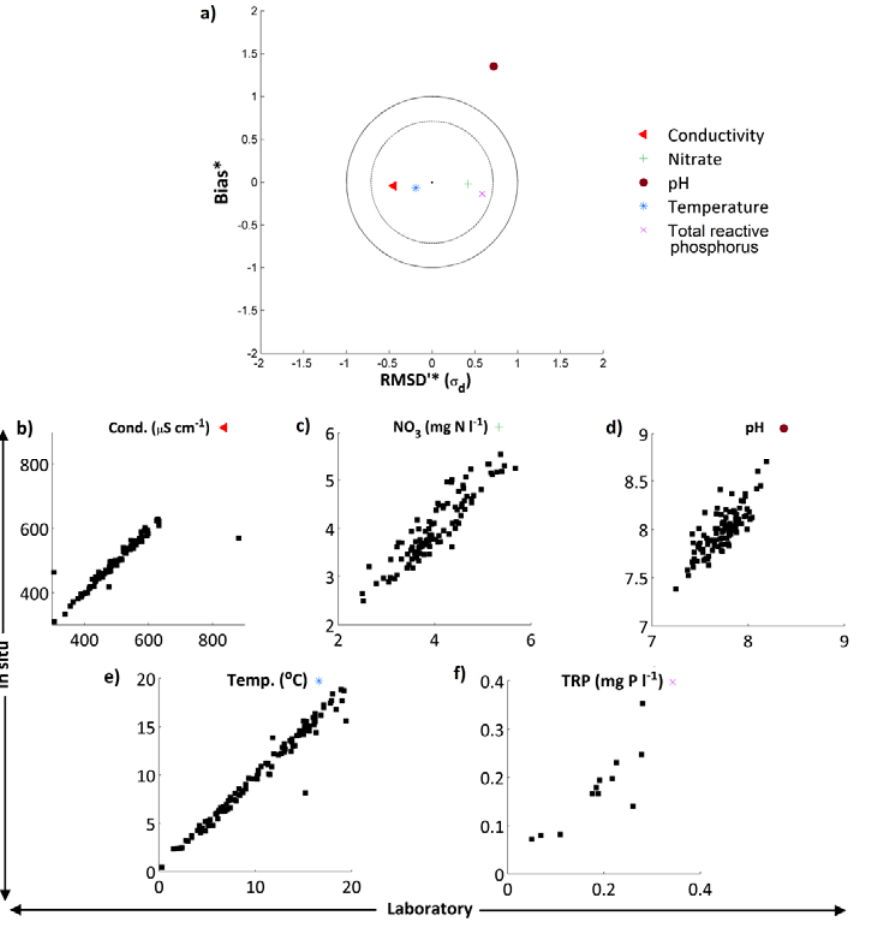
Figure 3. ( a ) Target diagram showing normalised unbiased RMSD [ RMSD (cid:1499) ′ —Equation (6)] — Equation (8)] against the multiplied by the sign of the standard deviation difference [ σ (cid:2914) normalised bias [ B (cid:1499) — Equation (7)] between the high-frequency/laboratory results. Results in the inner circle are considered to have excellent agreement, those in the outer circle to have good agreement. Subplots ( b )–( f ) show the in situ high-frequency measurements (y-axis) plotted against the laboratory measurements (x-axis) for each determinand.